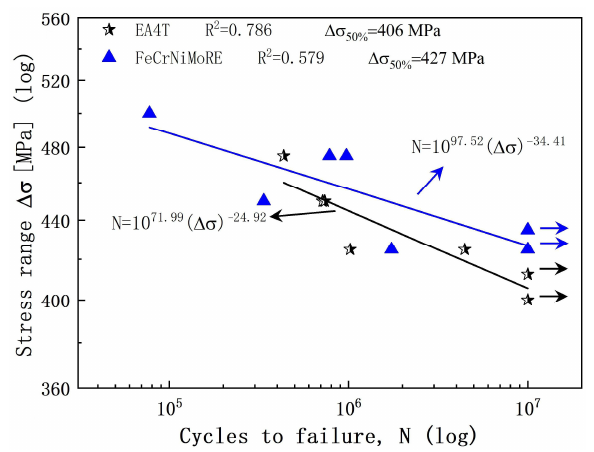
Figure 15. S-N curve of different samples.